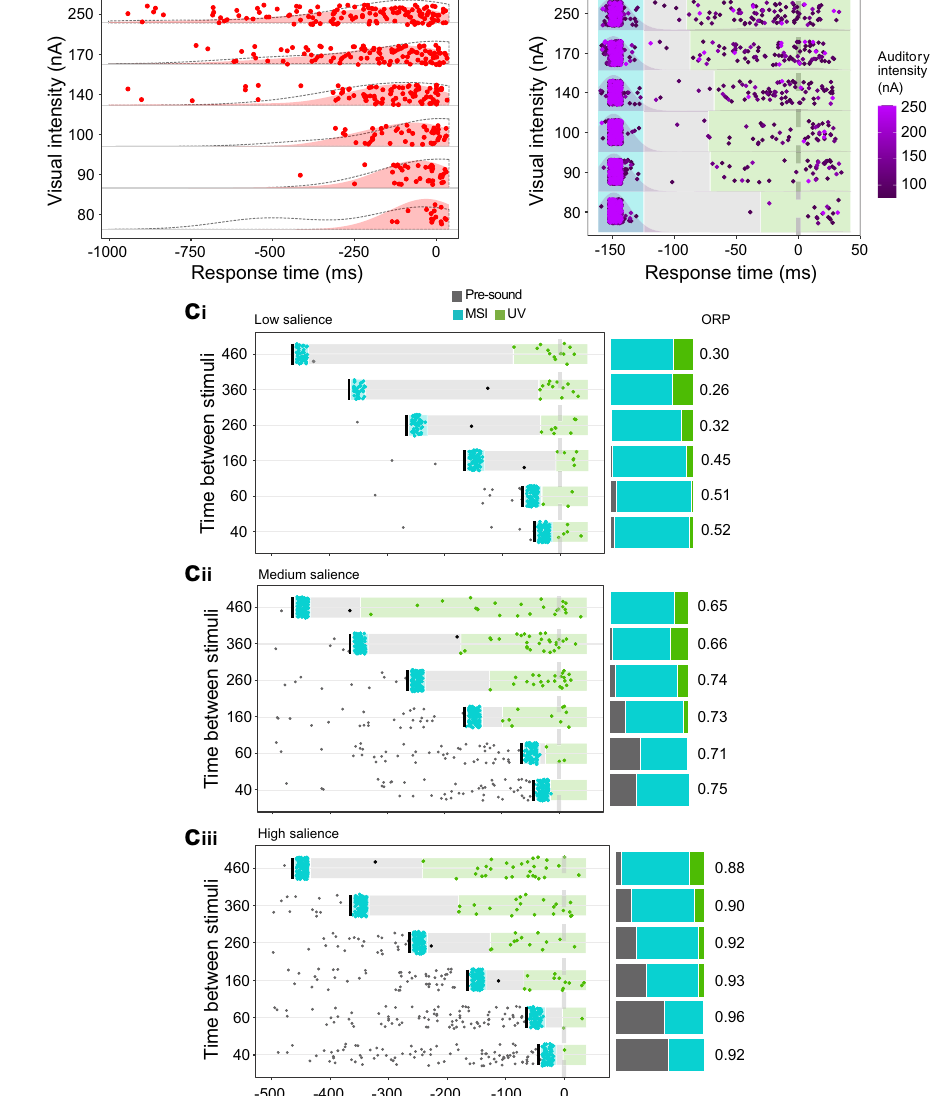
for the six intensities of unisensory visual stimuli used. The density distributions peak towards the end of the stimulus (at time 0) while higher intensities produce a higher proportion of early responses, i.e. the distribution tails to the left. Both effects, as well as the range of the model response times, matched those observed in the behavioral data (Fig. 3e). As in our empirical data, simulated multisensory responses after auditory stimulus onset were divided into three distinct periods (Fig. 6b). A high concentration of responses (between 82 and 97% depending on the contrast) occurred during the MSI period. This was followed by a sharp decrease in response probability during